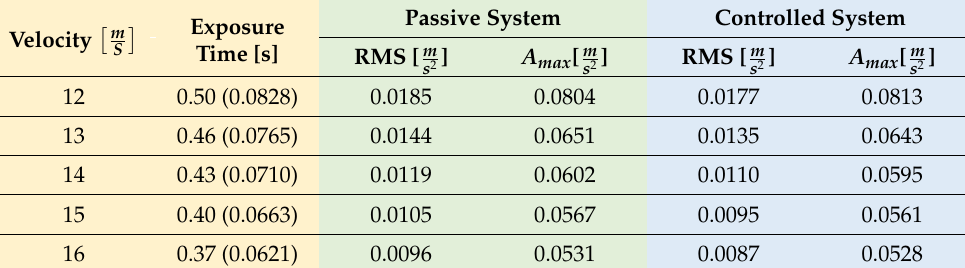
Table 4. The quality indicators of angular acceleration for roll